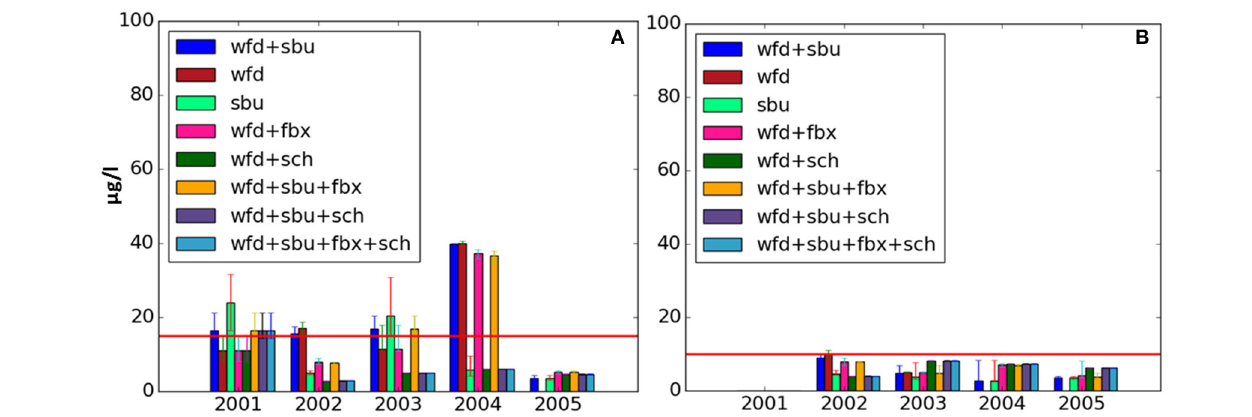
FIGURE 8 | Bar plot showing the results of the OSPAR COMP2 assessment for chlorophyll in coastal waters (A) and offshore waters (B) together with the 95% confidence intervals (notice that the confidence intervals are not symmetrical because they are confidence intervals of percentiles). Each bar represents one of the analyzed data aggregations given in section Aggregation scenarios. The red line shows the assessment